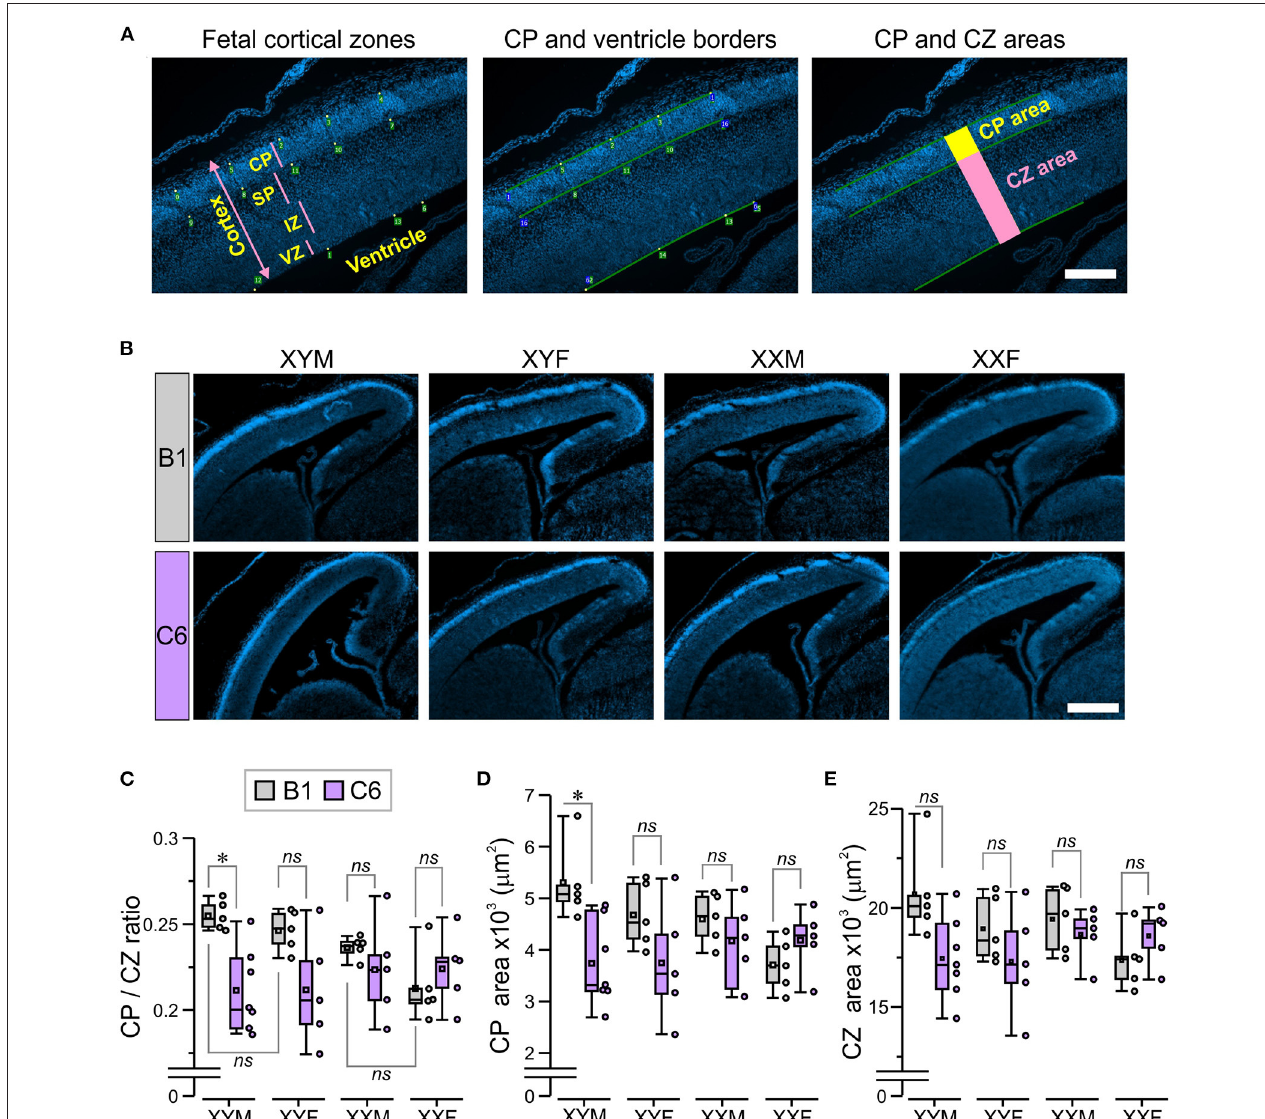
FIGURE 2 | The presence of the Y chromosome predisposes fetuses to develop a smaller cortical plate due to C6 exposure in utero . We established mating pairs between wild type C57Bl/6J female and XYM male mice. This mating scheme produced offspring with four genotypes, whose gonadal development was independent of sex chromosome complement. Offspring from 5 to 7 litters for each antibody were analyzed, with no more than two offspring per genotype selected from each litter. (A) The micrographs describe the technique for measuring the cortical plate (CP) area and the CZ area, which included the subplate (SP), intermediate zone (IZ), and ventricular zone (VZ; as explained in detail in the Methods. Scale = 100 µ m. (B) The panels show staining with DAPI, which was used to identify the CP in E15.5 fetuses. Scale = 400 µ m. (C–E) Box-and-whisker plots represent median and Q1–Q3 quartiles (whiskers are 10–90 range). Dots represent individual measurements. (C) Quantification of CP/CZ ratio shows that C6-exposed XYM fetuses had a smaller ratio relative to their respective B1-exposed controls. (D) Measurement of the CP area. Compared to their B1 control fetuses, C6-XYM fetuses had a significantly smaller CP area. (E) Measurement of the CZ area. There were no